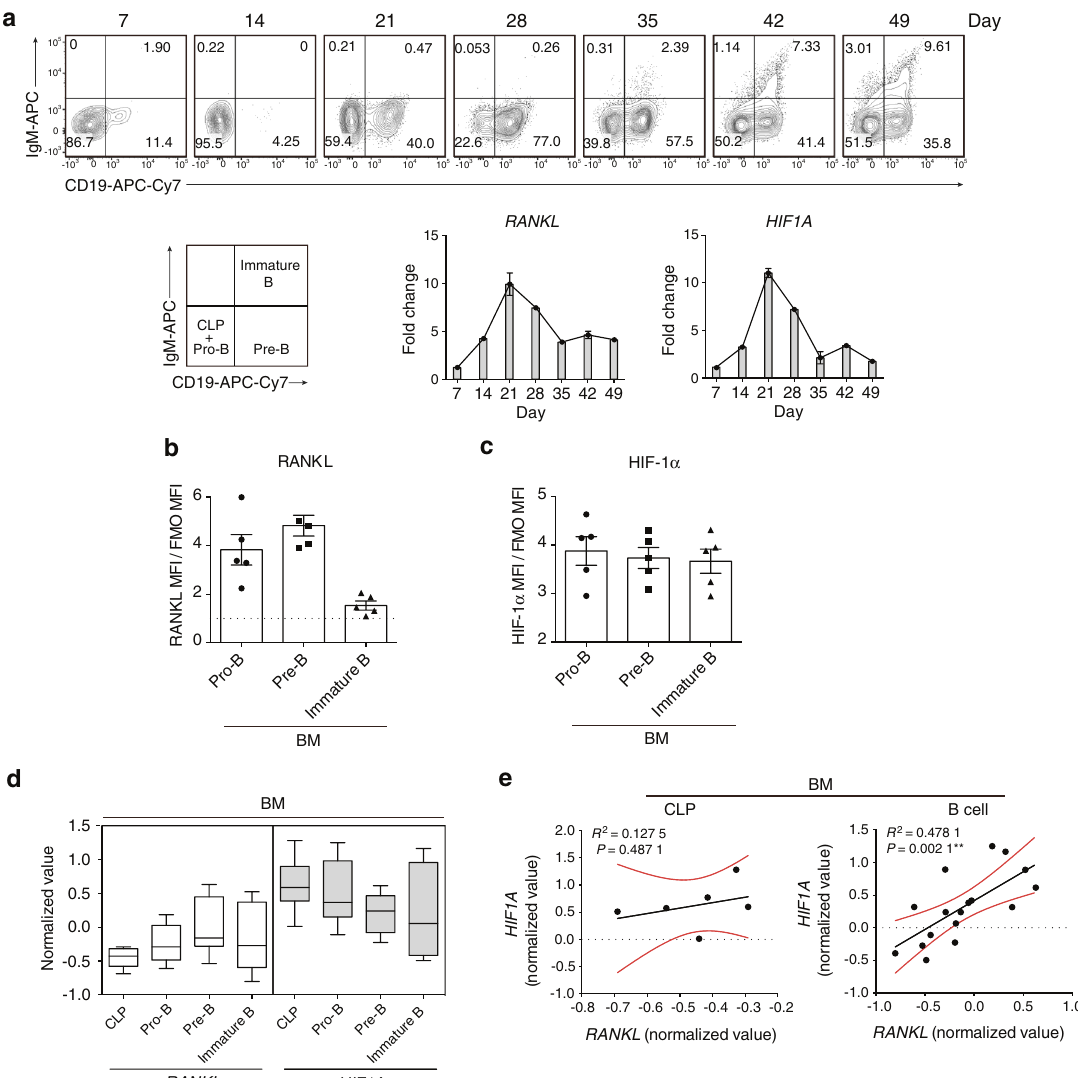
Fig. 6 RANKL gene expression is associated with HIF1A gene expression in human B cells. a Progressive development of cord blood-derived human CD34 + cells under B cell differentiation conditions for 49 days. RANKL and HIF1A gene expression was examined at the indicated time points ( n = 3). RANKL ( b ) and HIF-1 α ( c ) expression in human CD34 + cell-derived Pro-B, Pre-B, and immature B populations. d Normalized expression values of RANKL and HIF1A in human CLP, Pro-B, Pre-B, and immature B populations from the public gene expression database GSE14714. Bounds of boxes and whiskers represent the min-to-max normalized value of gene expression in each population. Medians are indicated in each box as centerline. e Correlation between HIF1A and RANKL expression values in human CLP and bone marrow B cells from the public gene expression database GSE14714 ( R 2 and P values are indicated). ** P < 0.01 by Pearson ’ s test ( e